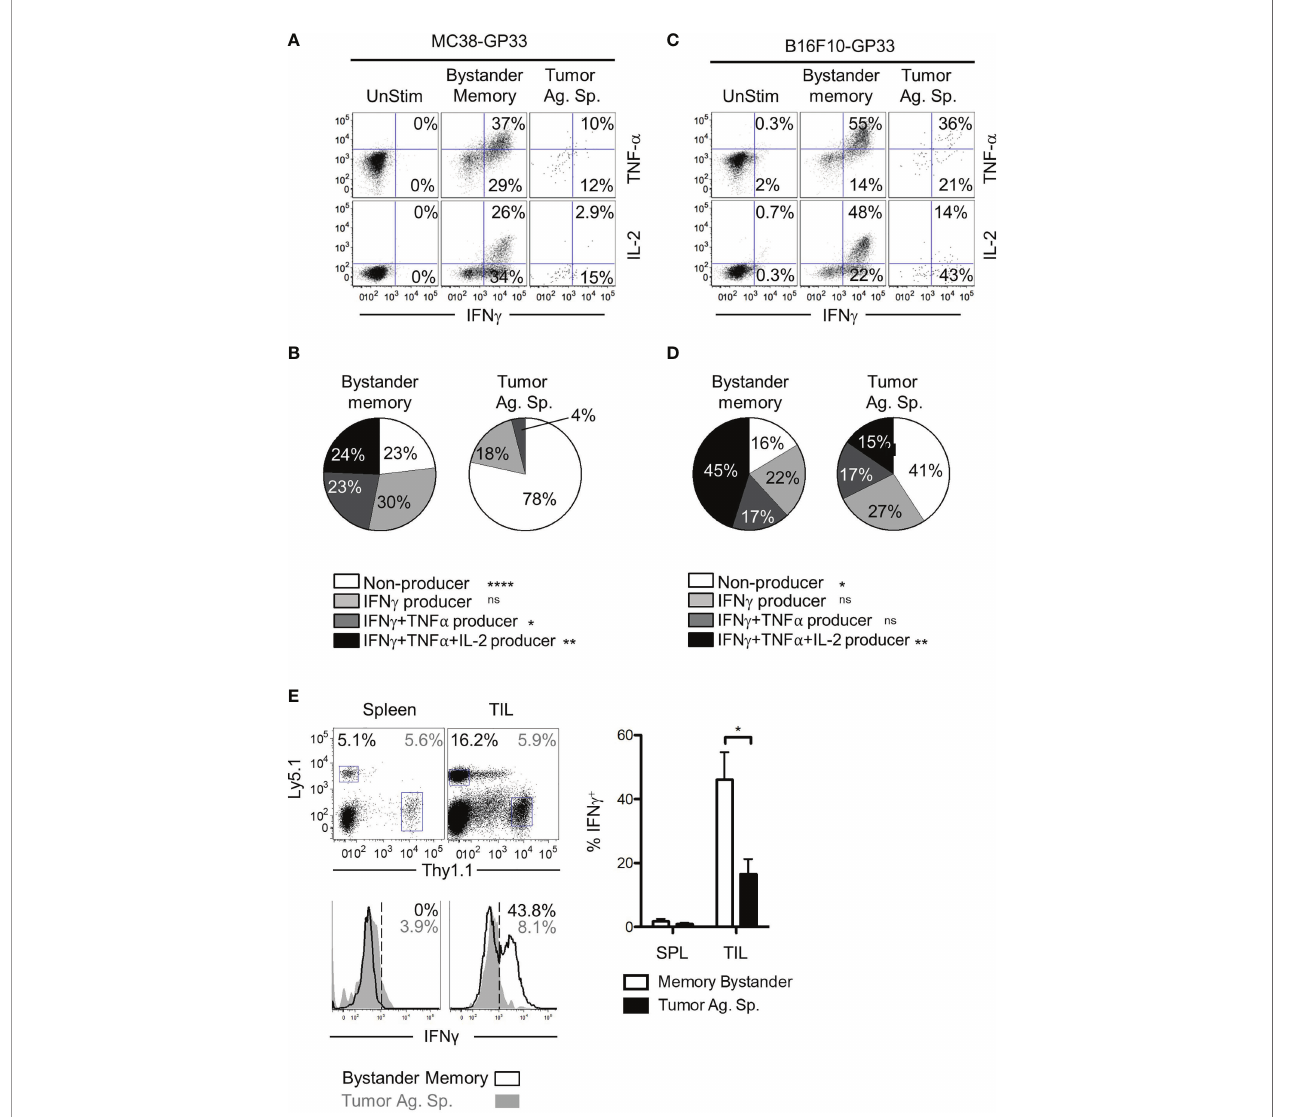
FIGURE 3 | Polyfunctionality of bystander memory T cells in tumor microenvironment. CD8 T cells from spleen and tumor of mice bearing MC38-GP33 tumors (A, B) or B16.F10-GP33 tumors (C, D) were stimulated with a CD3/ a CD28 for 5 hours in the presence of BFA and cytokine production was assessed. (A, C) . FACS plots are gated on total donor population (unstim), OT-I donors (bystander memory) or P14 donors (tumor ag-sp) cells from tumors. FACS plots show % of IFN- g /TNF- a double positive or % IFN- g /IL-2 double positive of each population. (B, D) . To assess the degree of polyfunctionality of each population of cells, the proportion of nonproducing (white), IFN- g + (light gray), IFN- g + TNF a + (dark gray) and IFN- g + TNF a + IL-2 + (black) donor CD8 T cells were plotted in pie charts. (E) . Established B16.F10-GP33 tumors were injected intratumorally with 30 ul PBS containing Ova peptide, GP33 peptide, and BFA to assess in situ cytokine response. Five hours later, the spleen and tumors were collected, and cells were assessed for IFN- g production. Gating of donor population is shown in the top panel, with Ly5.1 + memory bystanders and Thy1.1 + tumor antigen speci fi c CD8 T cells. Bottom panel show histograms for IFN- g in the spleen (left) and tumor (right). Percentage of IFN- g positive cells is shown in the upper right corner and is plotted in the bar chart to the right. Representative plots are shown from N=5 mice per group. Statistical signi fi cance was determined by ANOVA with multiple comparisons (B, D) or paired t-test (E) *p < 0.05, Data is representative of 3 independent experiments. **p < 0.01, ****p < 0.0001, ns, non-signi fi